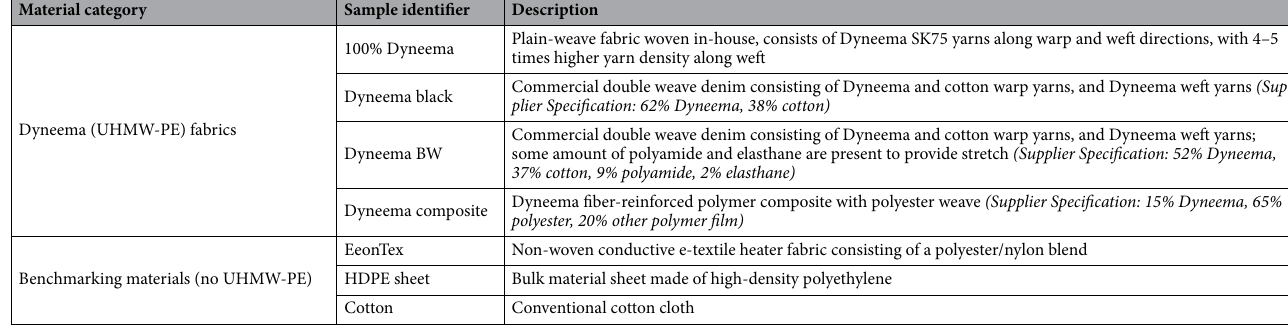
Table 2. Summary of the materials considered in this study.